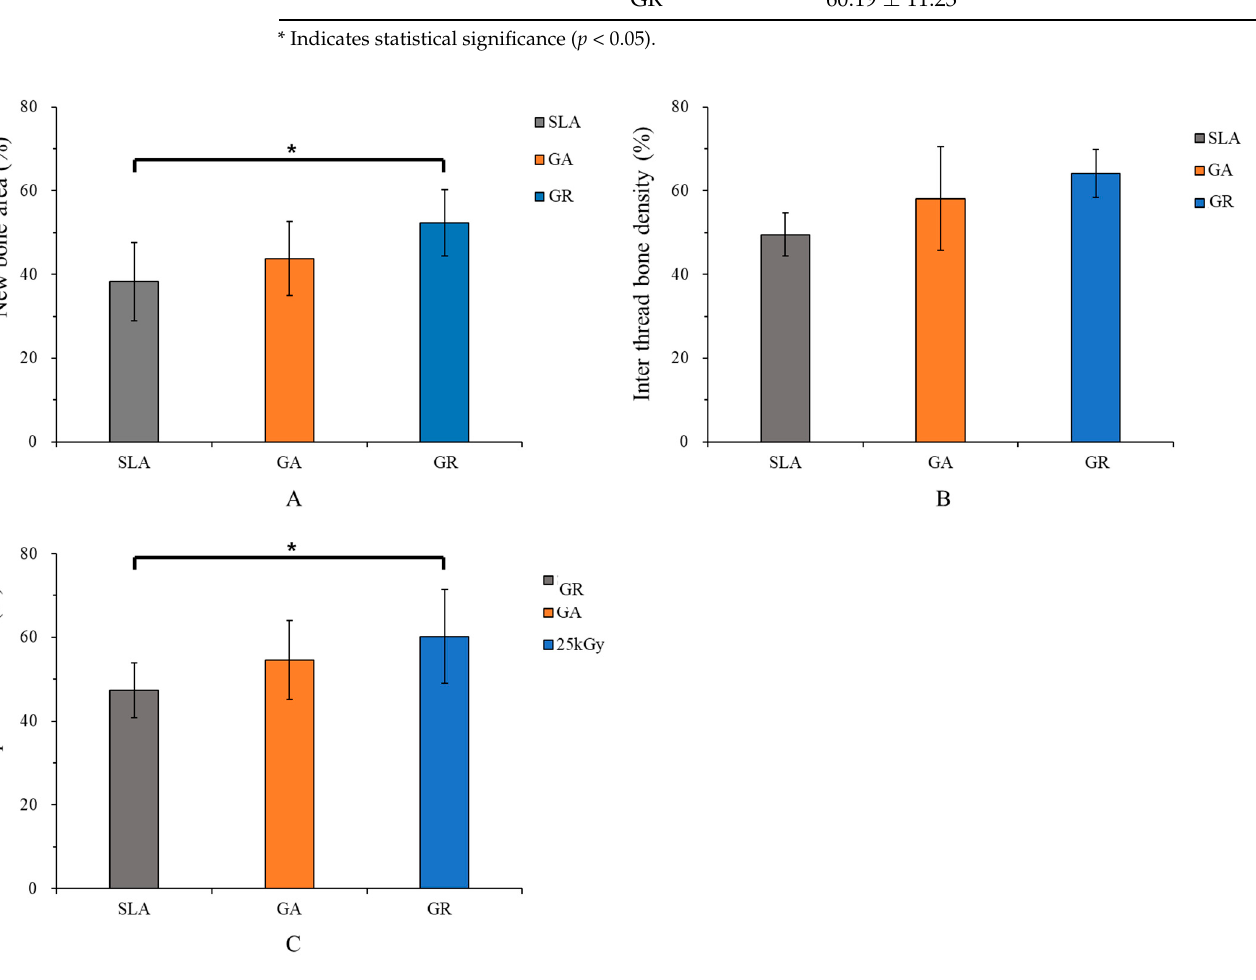
Figure 8. Histometric analysis within regions of interest (ROI). ( A ) New bone area (%), ( B ) Inter thread bone density (%), ( C ) Bone-implant contact (%). * Indicates statistical significance ( p < 0.05). Table 2. Mean values of new bone areas (NBAs), inter-thread bone densities (ITBDs), and bone to implant contacts (BICs) as determined by histometric analysis.